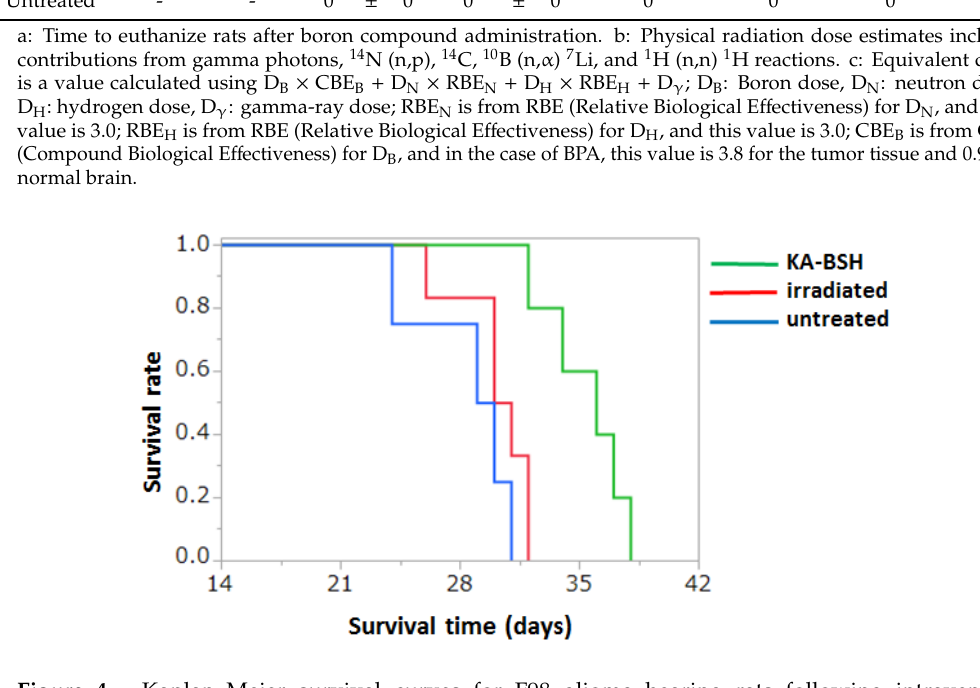
Figure 4. Kaplan–Meier survival curves for F98 glioma bearing rats following intravenous administration of KA-BSH followed by BNCT. Survival times in days after implantation have been plotted for untreated animals (blue line), irradiated controls (red line), and KA-BSH (green line). Median survival times of the KA-BSH group, neutron irradiation only group, and untreated group were 35.4 ± 8.0, 30.2 ± 2.2, and 28.5 ± 3.1 days, respectively. There were statistically significant differences between the KA-BSH group and neutron irradiation only group ( p = 0.0053) and between the KA-BSH group and untreated group ( p = 0.0027).